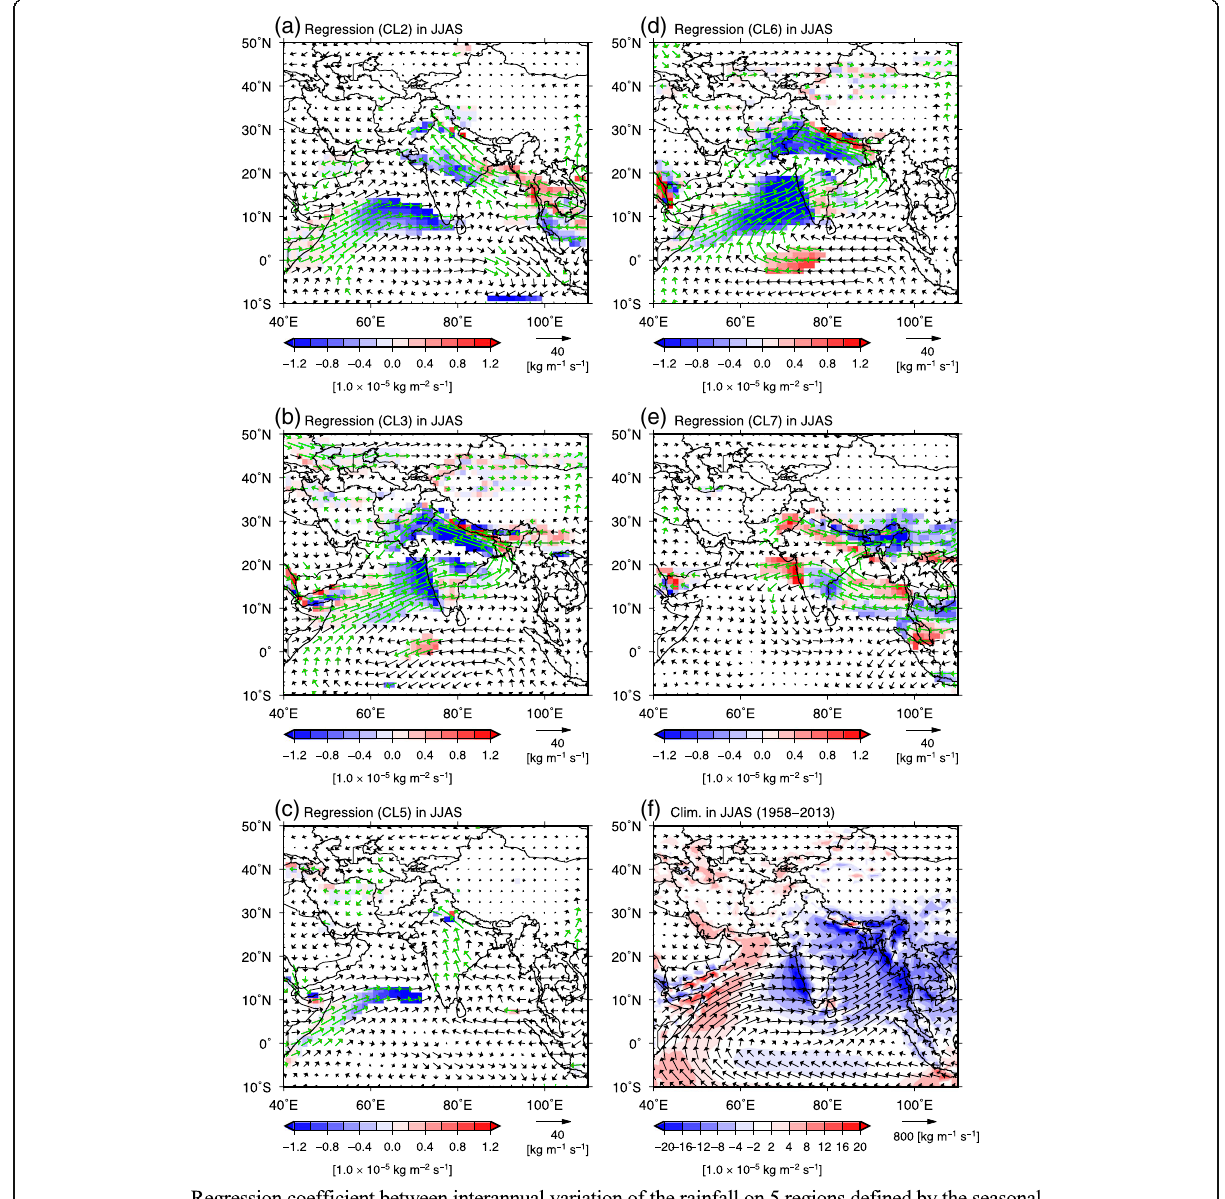
Fig. 8 Regression coefficient of rainfall and water vapor ( WV ) flux for the summer monsoon season. The regression coefficient (objective variable is precipitation) between interannual variation of rainfall and water vapor flux (kg m − 1 s − 1 ) (vector) and its divergence (× 10 − 5 kg m − 1 s − 1 ) (shaded) as the regression coefficient (objective variable is precipitation) for each cluster ( a ) – ( e ), and the distribution of climatological averaged values for 1958 – 2013 for the water vapor flux and divergence ( f ). Colored (green) vector shows significance over the 2% level based on the Student t